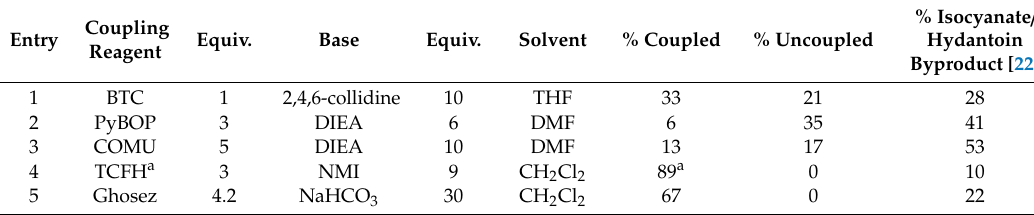
Table 1. Optimization of coupling to resin-bound